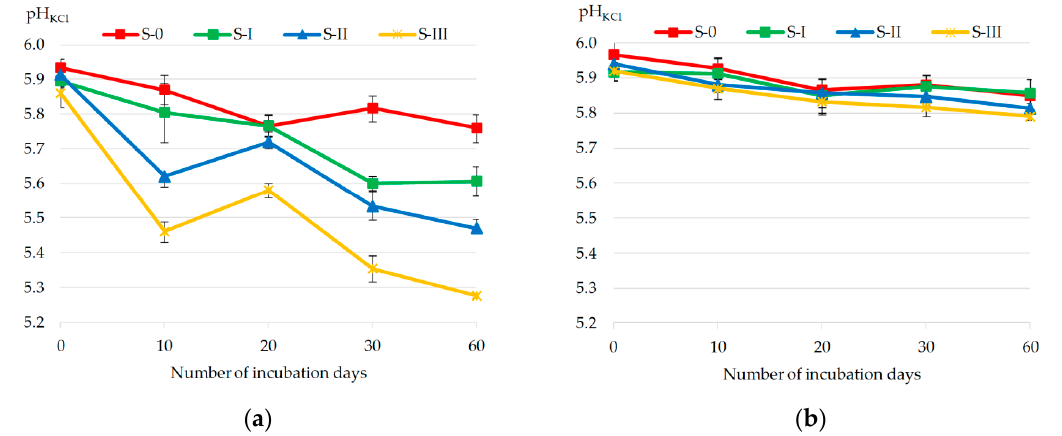
Figure 1. pH KCl value of soils throughout the experiment: ( a ) light soil; ( b ) heavy soil. S-0: control soil (with no sulfur addition); S-I: soil with the addition of sulfur pulp at dose I; S-II: soil with the addition of sulfur pulp at dose II; S-III: soil with the addition of sulfur pulp at dose III. Error bars represent standard deviation.